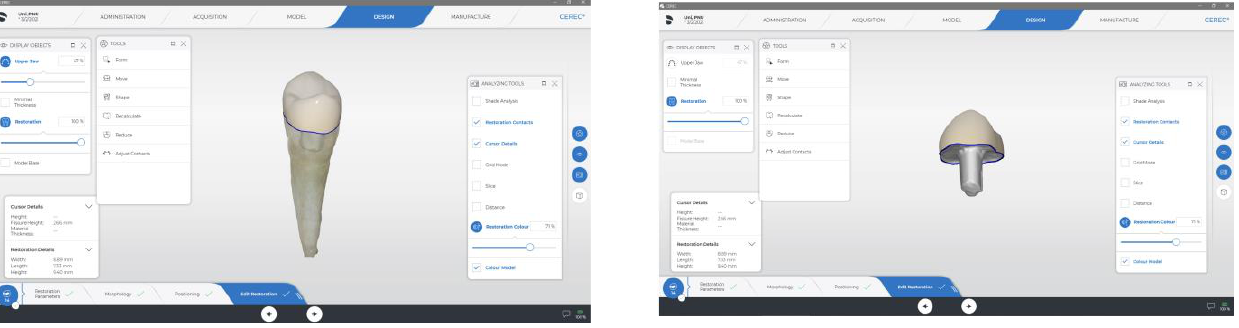
Figure 4. Primescan generated design of endocrown without intraradicular extension.